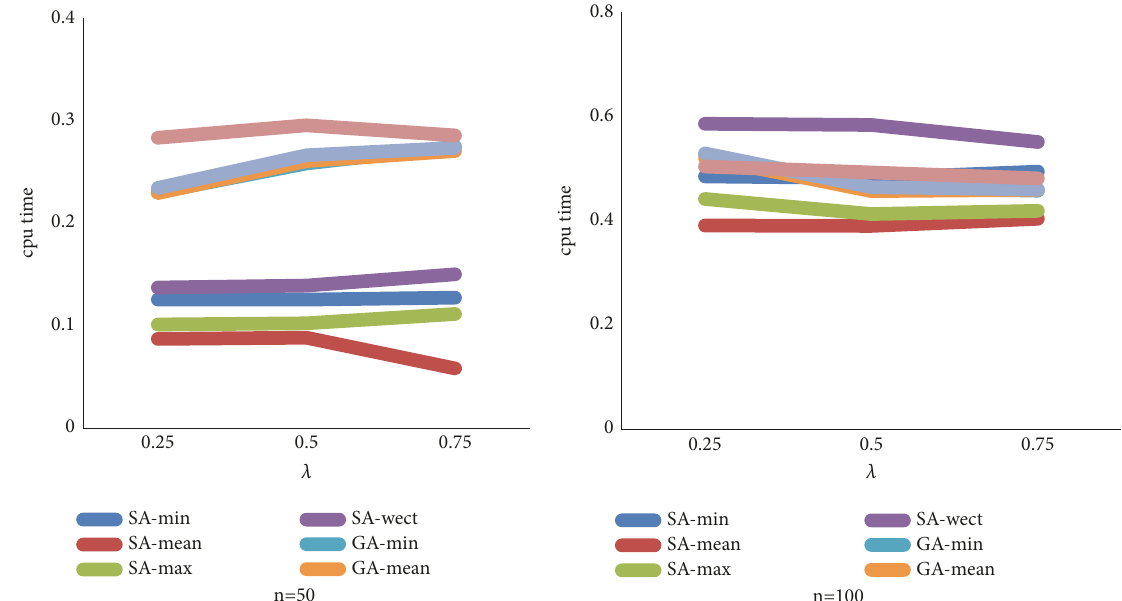
Figure 4: Change of CPU time for each 𝑛 as 𝜆 increases for SAs and GAs for large number of orders.